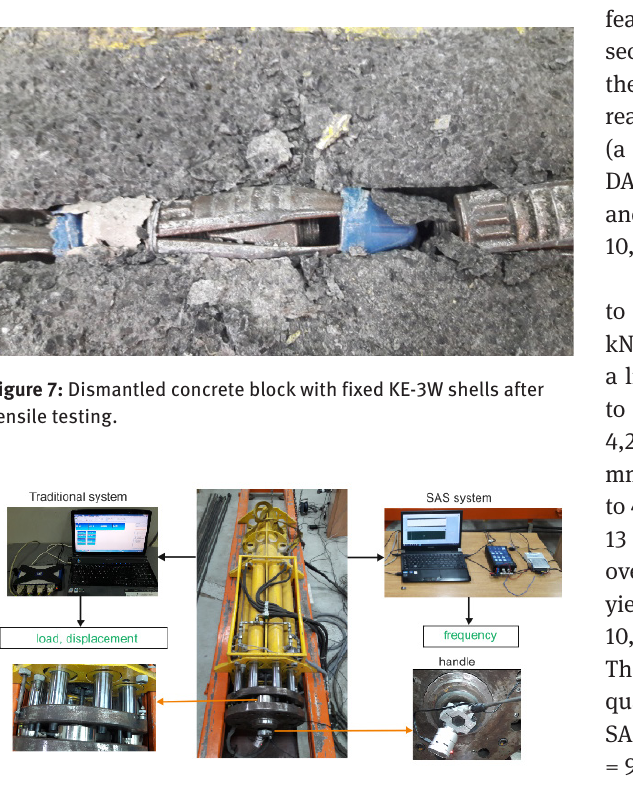
Figure 6: Load and displacement behavior of the KE-3W expansion- shell bolt.